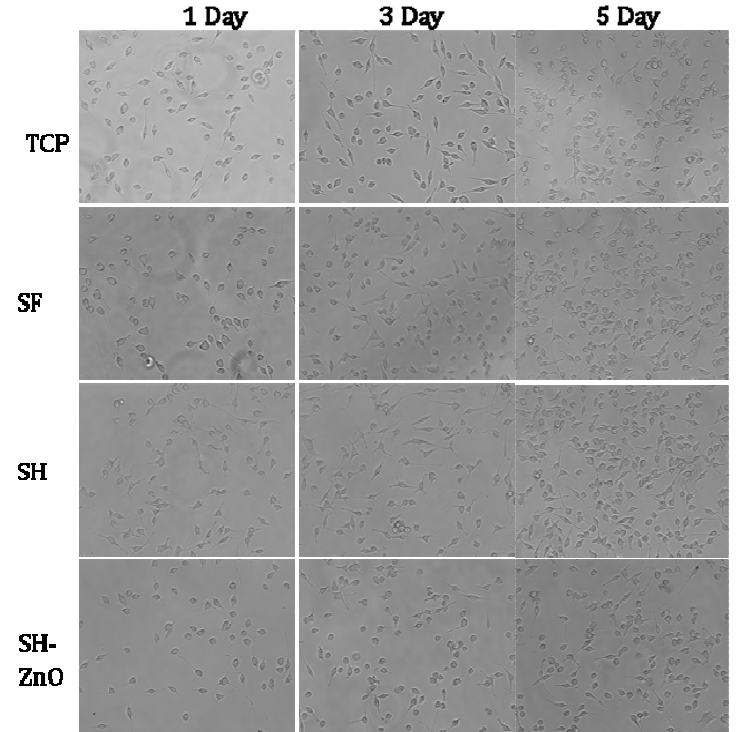
Figure 8. Images of Phase contrast microscopy of different samples.